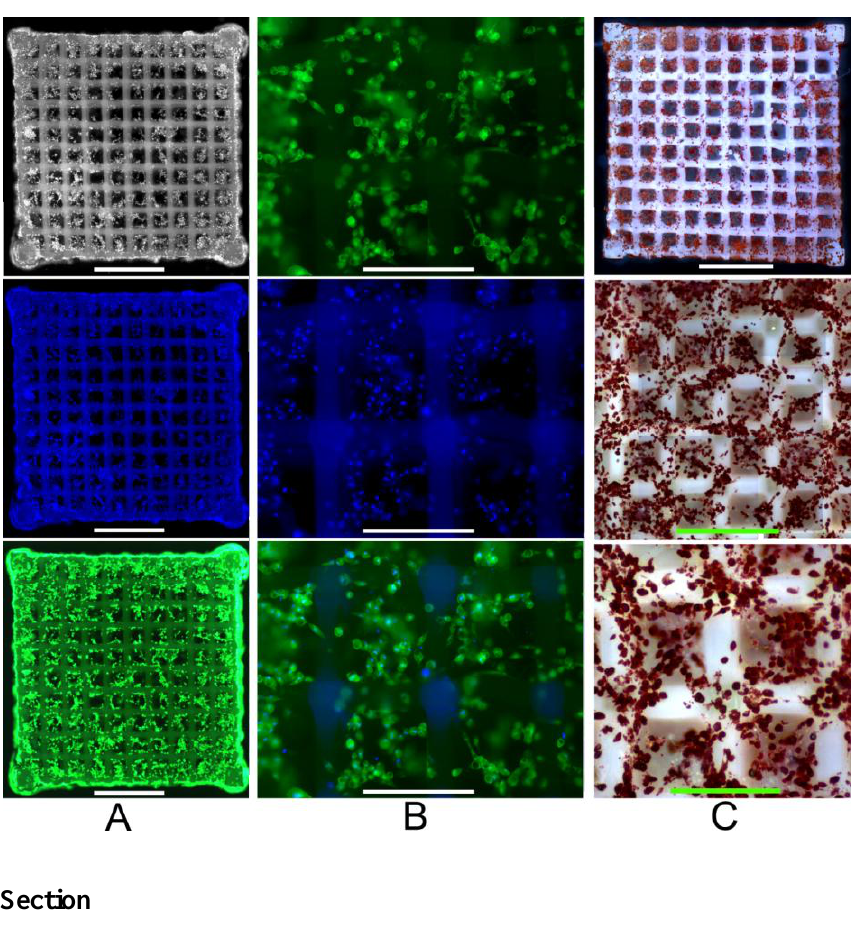
Figure 4. Human ASCs within the 2PP Scaffold at day 22; ( a) Staining with Calcein AM (cell viability stain, green fluorescence) and Hoechst 33,342 (cell nuclei stain, blue fluorescence) indicates the cell distribution (scale bars represent 1 mm); ( b ) Magnified scaffold view (scale bars represent 300 µm); ( c ) Oil Red O staining ( i.e ., indicator of intracellular lipid accumulation) (scale bars represent from top to bottom 1mm, 600 µm and 300 µm